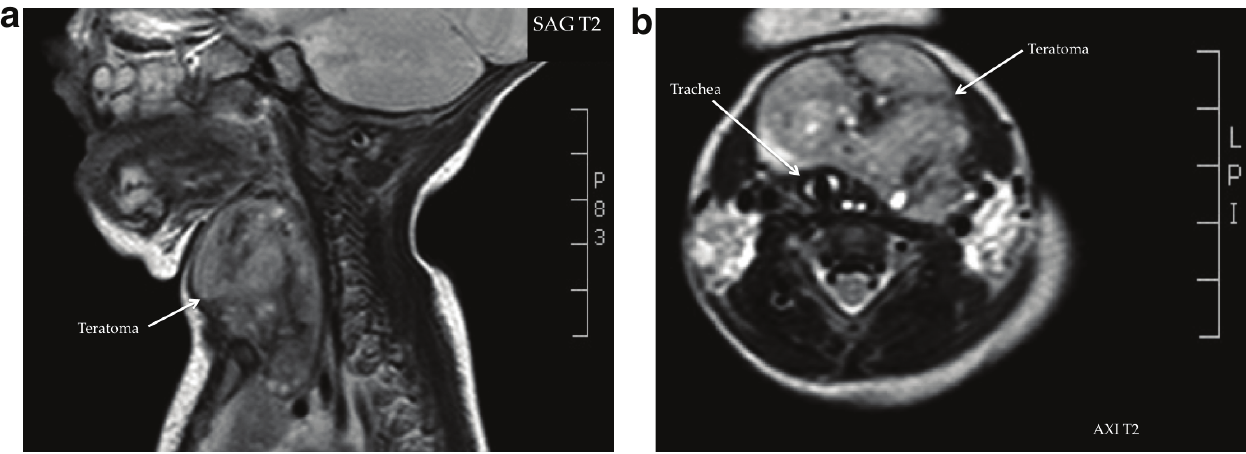
Figure 3. a . Sagittal MRI (T2) of the neck showing the teratoma. b . Axial MRI (T2) of the neck showing the teratoma and the tracheal displacement.